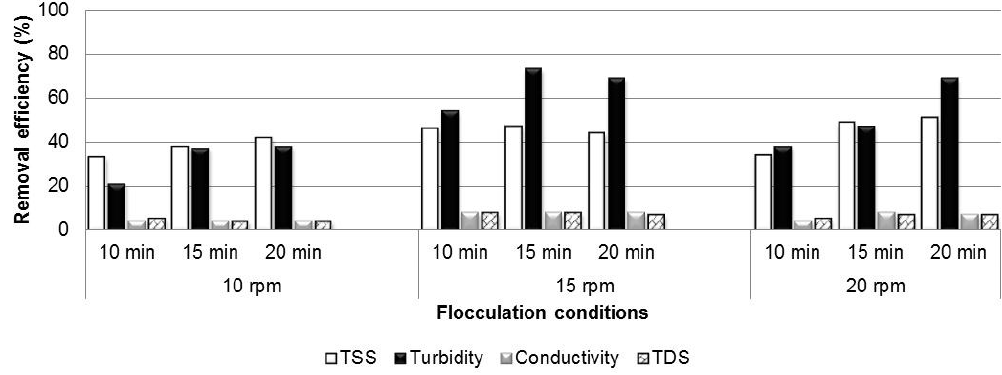
Figure 5. Optimum conditions for flocculation of liquid detergent graywater.